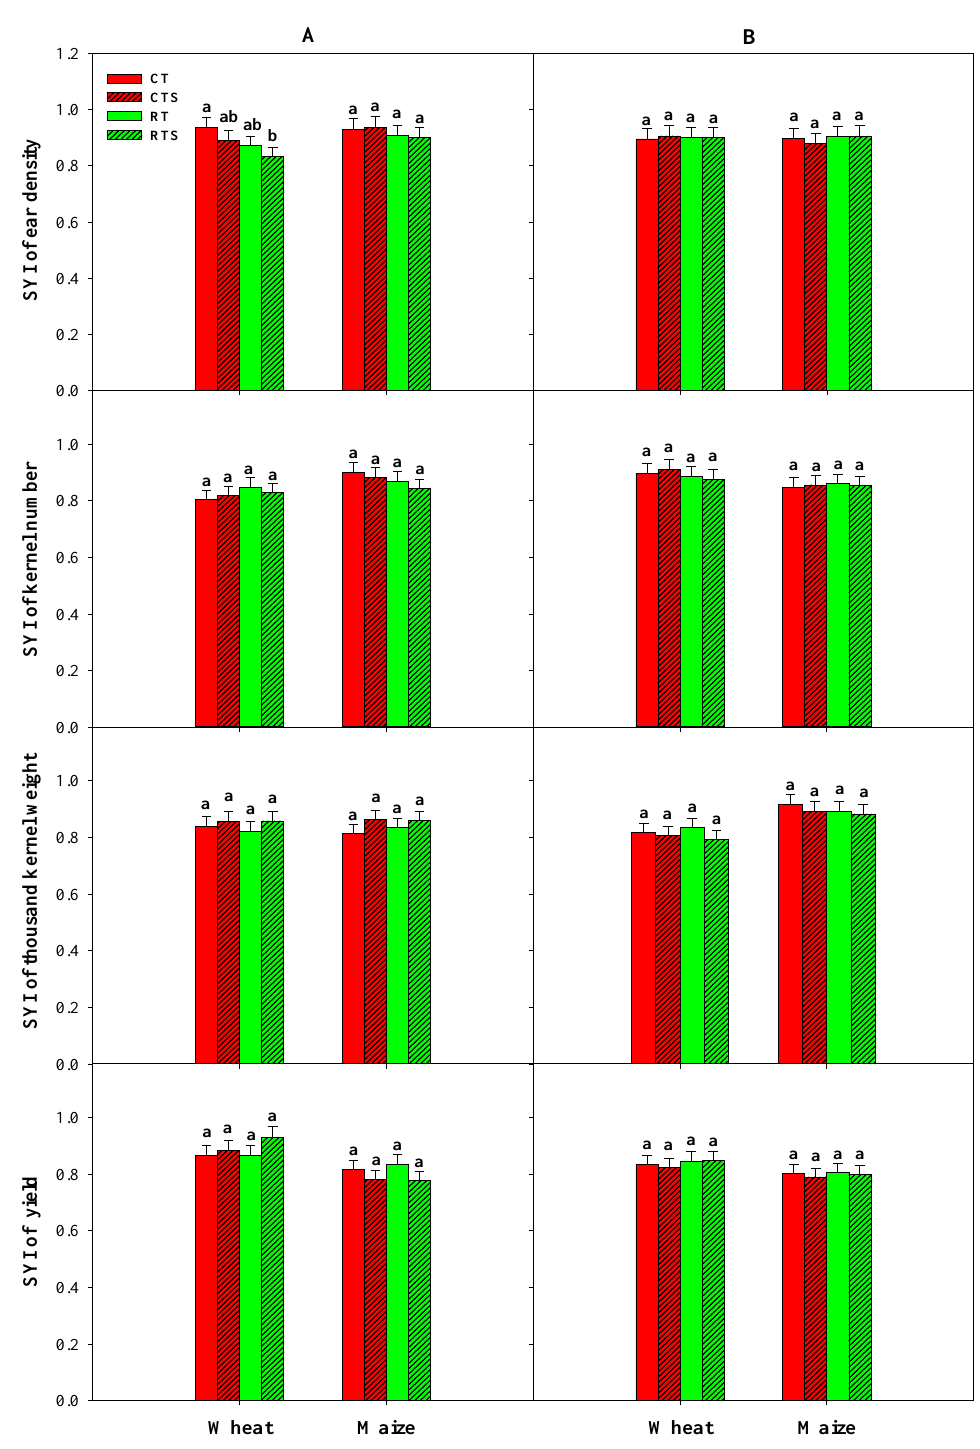
Figure 8. Yield and yield component stability of wheat and maize under tillage and straw returning practices at the Tai’an ( A ) and Longkou ( B ) experimental sites. CT: conventional tillage without straw returning; CTS: conventional tillage with straw returning; RT: rotary tillage without straw returning; RTS: rotary tillage with straw returning. T-like lines: standard deviation. Different letters in each group indicate significant differences between different treatments ( p < 0.05 ; Duncan’s test).